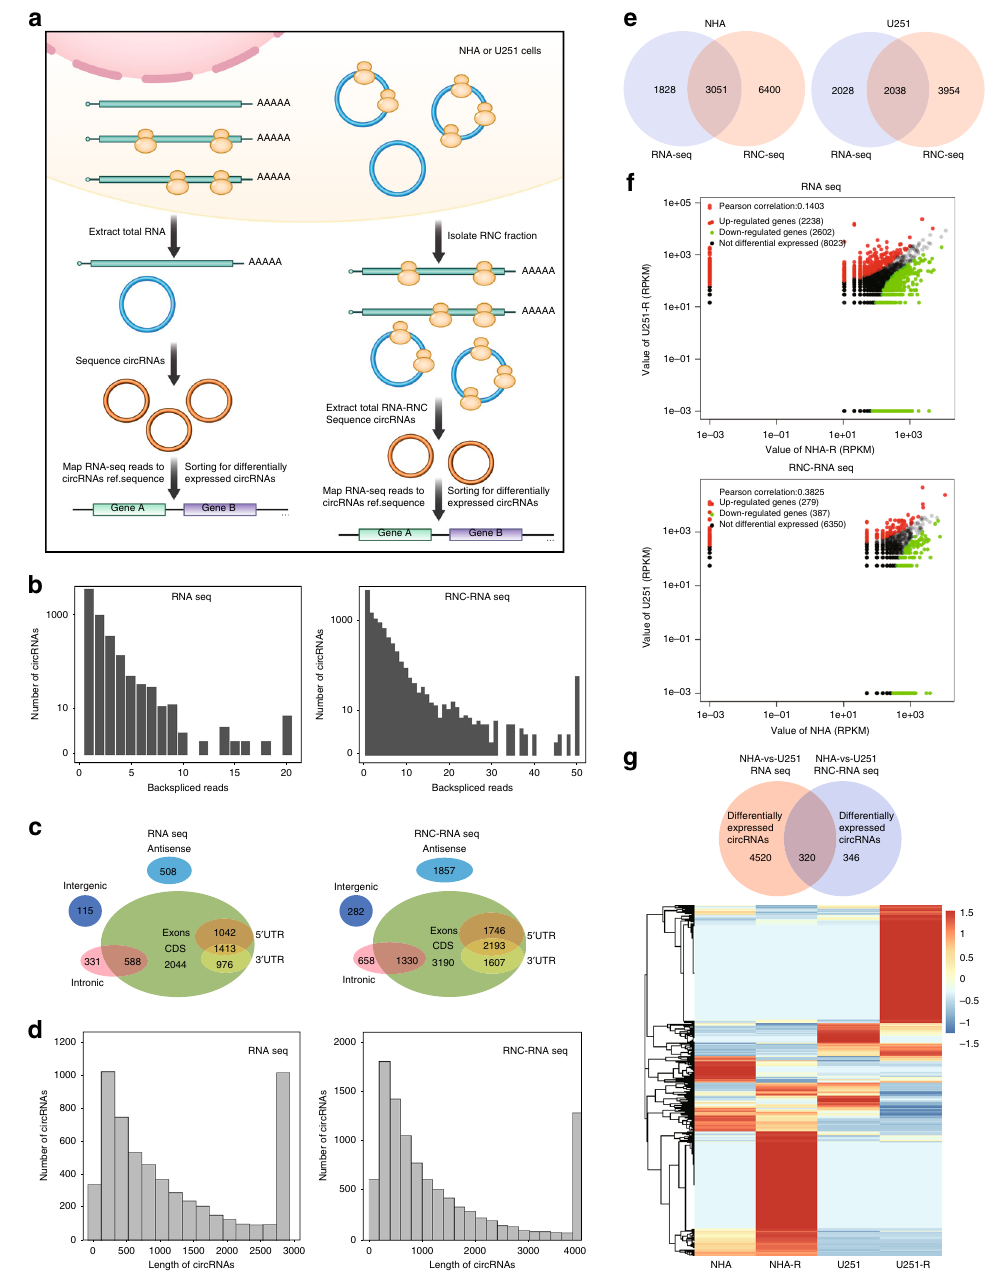
Fig. 1 Translatome sequencing and proteome pro fi ling of potential coding circRNAs in normal and cancer cells. a Illustration of the screening protocol. Brie fl y, total RNAs or RNC-RNAs were isolated separately from NHA or U251 cells. Equal amounts of total RNA or RNC-RNA were reverse-transcribed and subjected to deep RNA sequencing. Identi fi ed differentially expressed circRNAs were annotated in the genome, and the host genes were cross-matched between NHA and U251. b RNA-seq read abundance distribution of identi fi ed circRNAs. Upper, total RNA seq; Lower, RNC-RNA seq. X -axis: the back- spliced read numbers of circRNAs detected by sequencing. Y -axis: the abundance of circRNAs classi fi ed by different read numbers. The majority of called circRNAs in the study were supported by more than 10 reads. c Venn plot showing the number of circRNAs derived from different genomic regions. Upper, total RNA seq; lower, RNC-RNA seq. d Length distribution of the identi fi ed circRNAs. Upper, total RNA seq; lower, RNC-RNA seq. X -axis: the length of circRNAs detected in this study. Y -axis: the abundance of circRNAs classi fi ed by different lengths. e The Venn plot of the numbers of called circRNAs in NHA and U251 by RNA-seq or RNC-seq. RNC-seq identi fi ed more circRNAs due to the higher sequencing depth (see Supplementary Figure 1). f Scatter plot of all differentially expressed circRNAs between NHA and U251 cells. Upper, total RNA-seq; lower, RNC-seq ( x and y axes represent circRNA expression value, RPKM). g Upper, differentially expressed circRNAs between NHA and U251 cells in total RNA or RNC-RNA were cross-matched. A total of 320 differentially expressed circRNAs were identi fi ed, generated from 274 host genes. Lower, the host genes were subjected to GO enrichment analysis (The gene expression value in heatmap was normalized by Z score in each